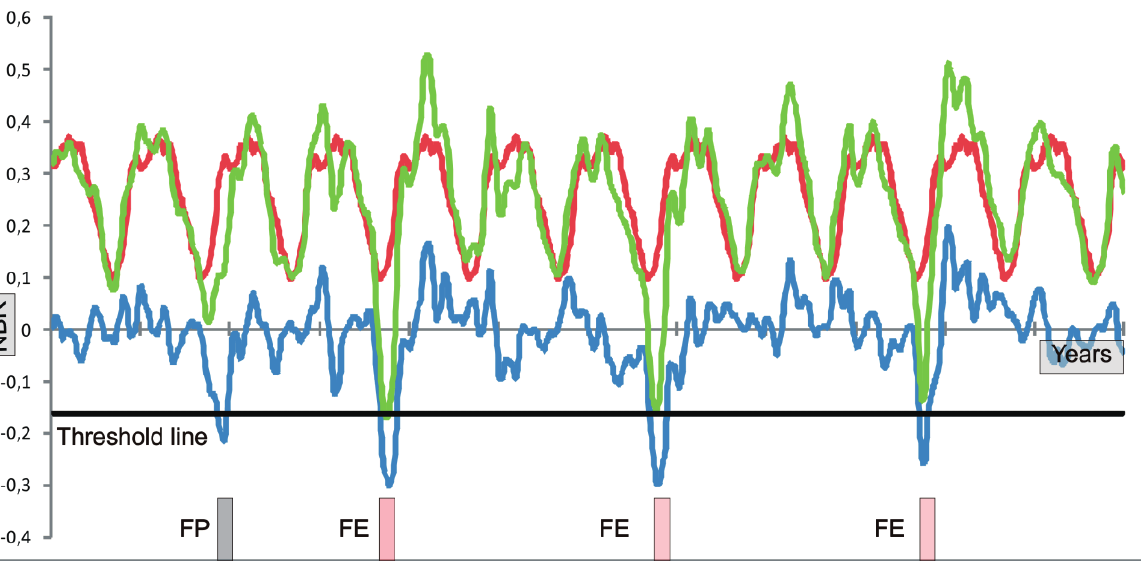
Figure 22. Detection of burned areas using the interannual phenological deviation, where the MODIS-NBR time series is the green line, the time series with a one-year lag is the red line, the dNBR curve is the blue line and the threshold line is the black line. Fire events (FE) and false positive (FP) are marked on the bottom of the